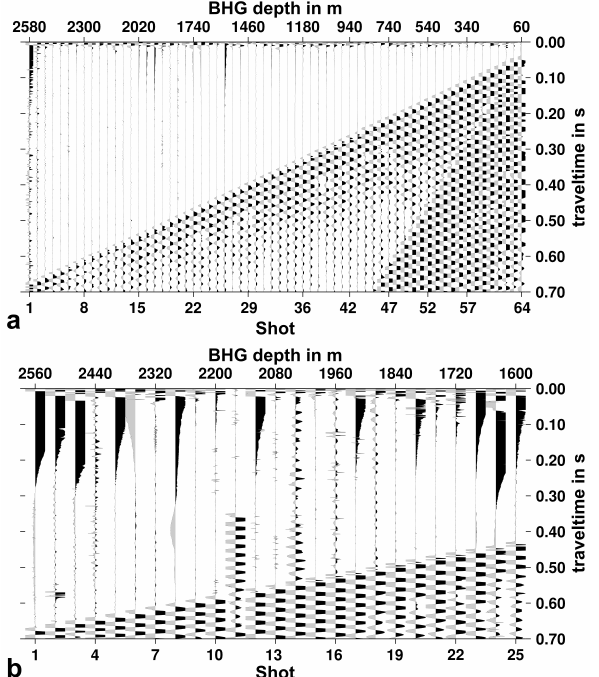
Figure 4. Recorded first arrivals from the VSP surveys with deto- nation cord ( a , survey 20130545) and booster ( b , survey 20130546) as the source. The top ordinate gives the location and, hence, the depth of the borehole geophone (BHG); the bottom ordinate shows the shot number. In (a) not only the direct P-wave arrival is visi- ble but also a borehole-guided wave travelling with a velocity of 1150ms − 1 . Depth is given here to top of casing.